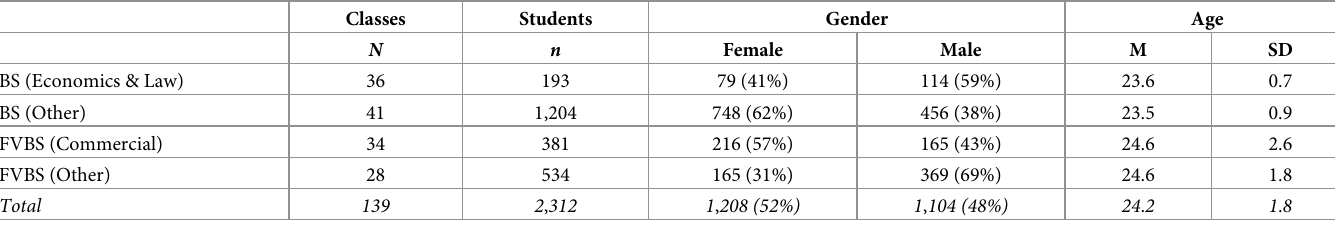
Table 3. Longitudinal sample (weighted).